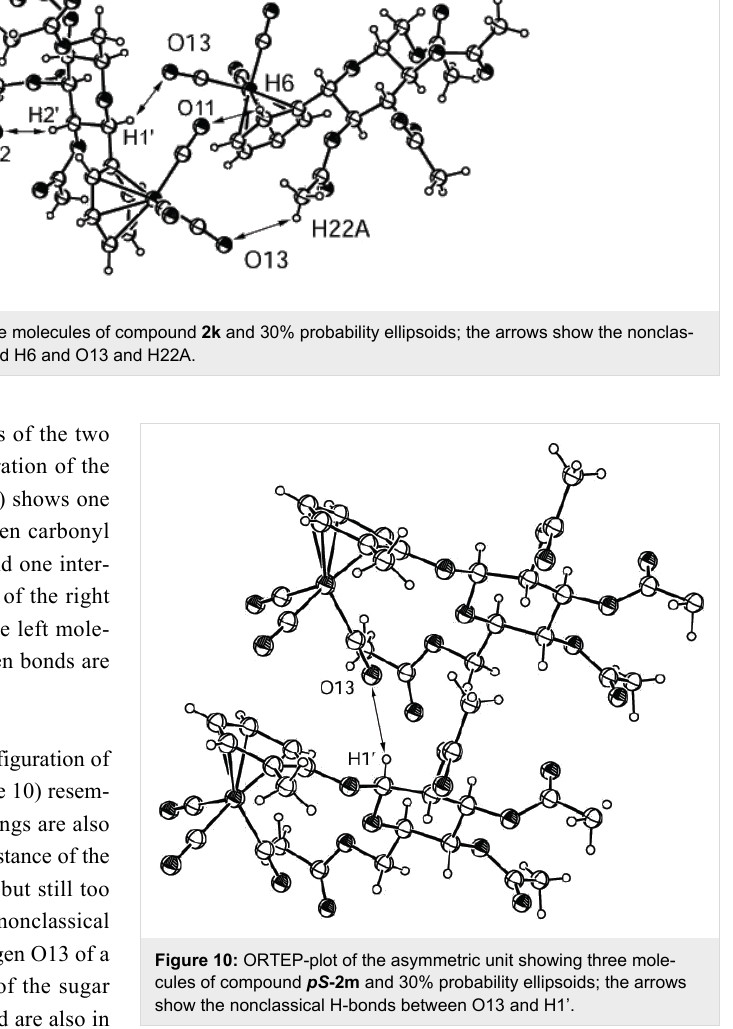
Figure 10: ORTEP-plot of the asymmetric unit showing three mole- cules of compound pS -2m and 30% probability ellipsoids; the arrows show the nonclassical H-bonds between O13 and